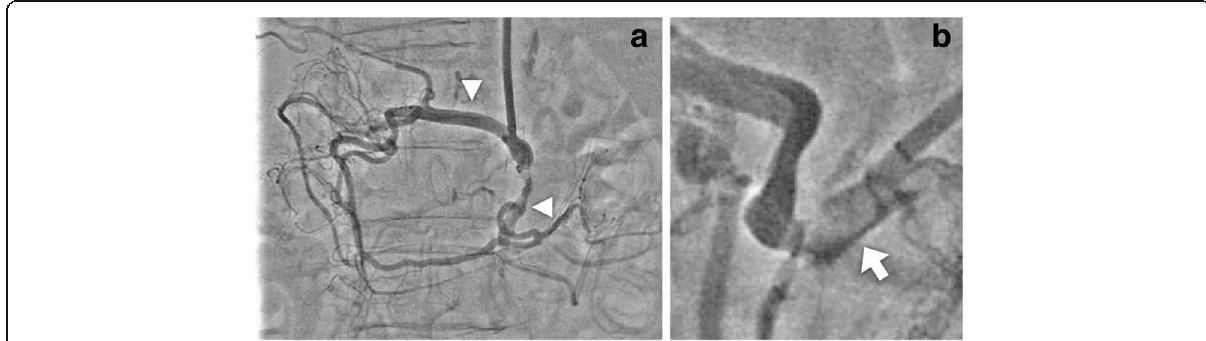
Fig. 2 Angiography revealed the anatomical variations of the SMA replacing the common hepatic artery ( a ), and severe stenosis of the origin of the SMA with calcification (arrow) ( b